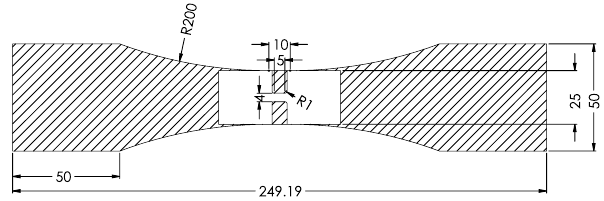
Fig. 2. Specimen geometry for fatigue loading and dynamic tensile testing. The specimen used for the experiments in the Hopkinson apparatus is extracted from the fatigue specimen after cyclic loading. See also figure 3.